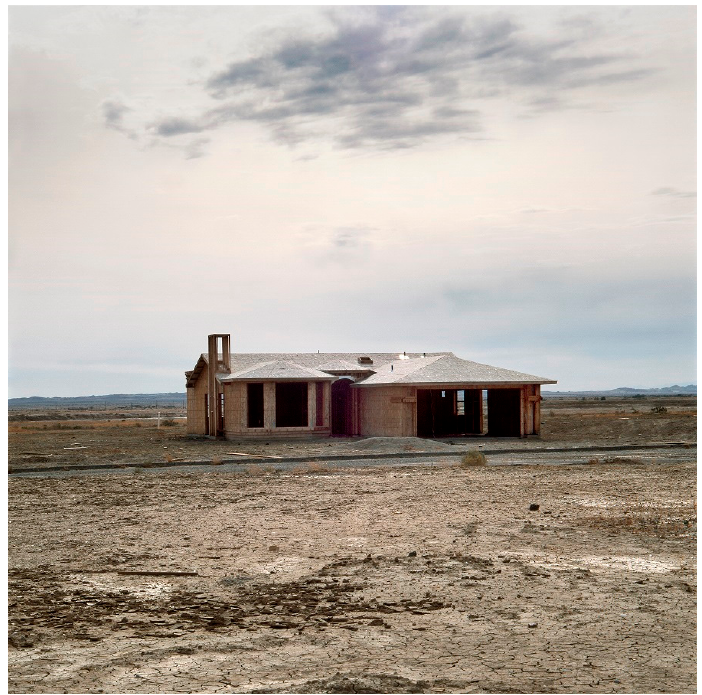
Figure 27. Anthony Hernandez, Discarded #3 (2012), © Anthony Hernandez.